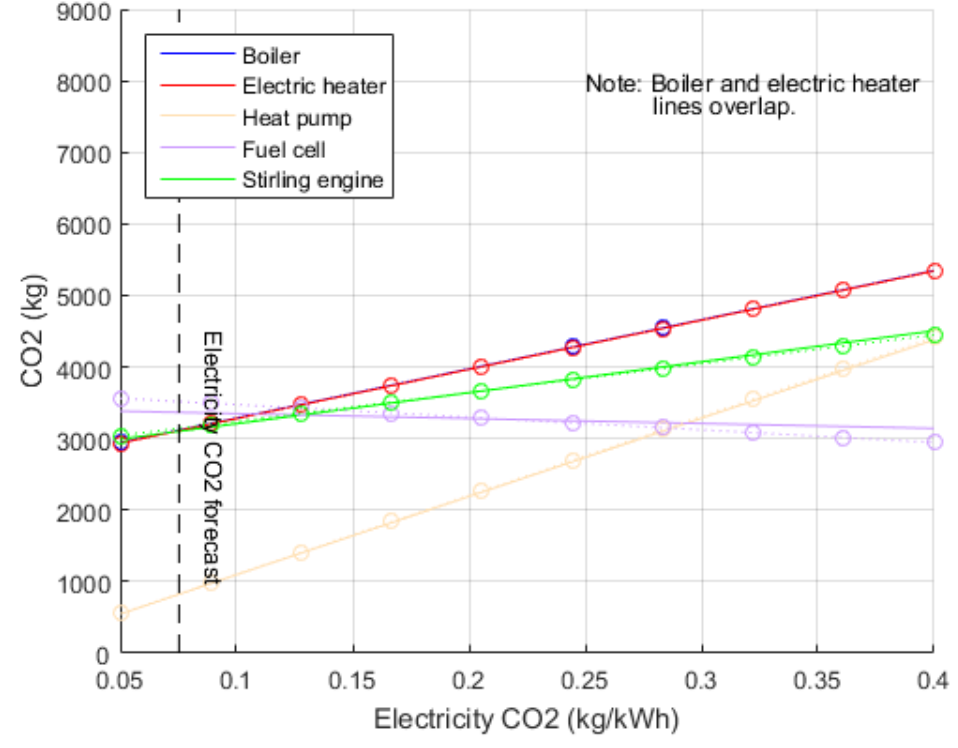
Figure 8. Emission sensitivity to carbon intensity of the electricity grid in the short run (solid lines) and long run (dotted lines with circle markers) regimes.